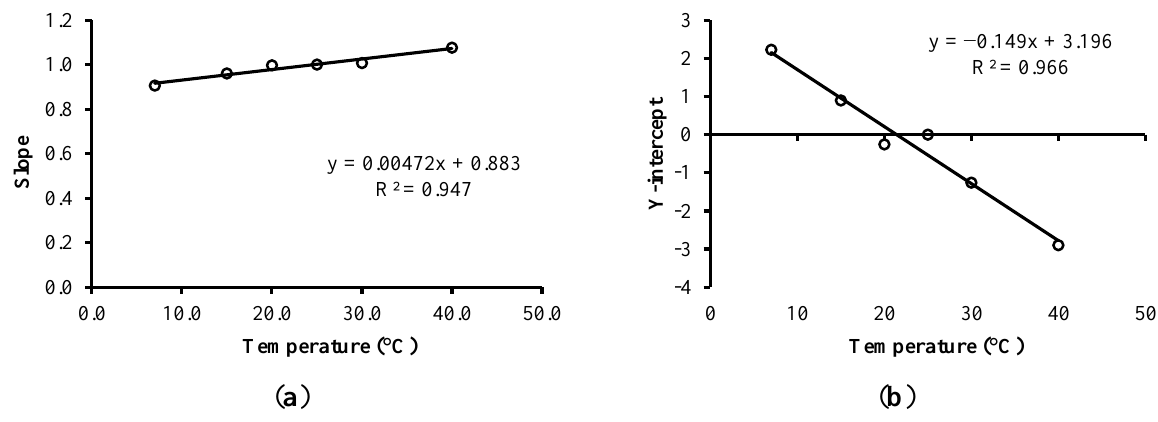
Figure 8. ( a ) Correlation between the temperature of the solutions and the slopes of the models for each temperature; ( b ) Correlation between the temperature of the solutions and the Y-intercepts of the models for each